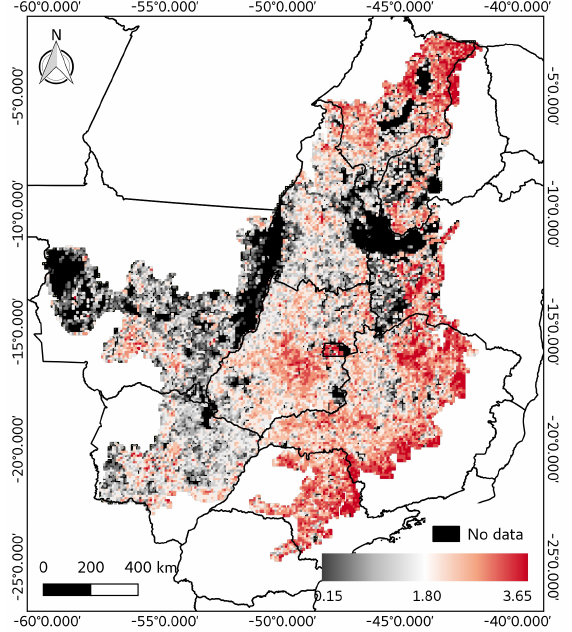
Figure 6. Logarithmic map of rural population density in the Cerrado based on CENEFE and Census